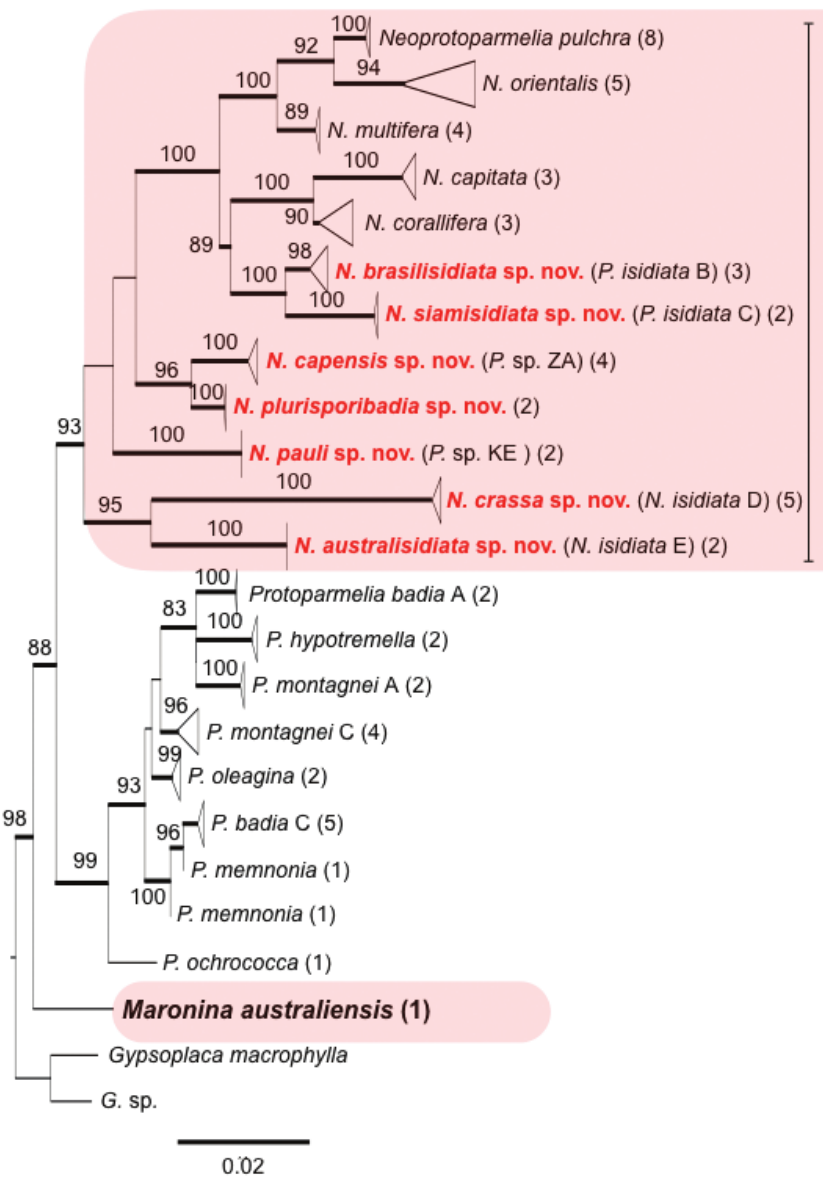
Figure 1. Phylogeny of Protoparmelioideae based on maximum likelihood analysis of ITS rDNA se- quences of Protoparmelia and Neoprotoparmelia ( Maronina s.l.). Numbers above branches indicate boot- strap support. Terminal clades were collapsed at the species level for clarity of presentation. The length of the triangle corresponds to branch lengths. Numbers in parentheses indicate number of specimens included in collapsed clade. Voucher information of each specimen in a clade is given in Table 1; New Neoprotoparmelia species are marked in red and